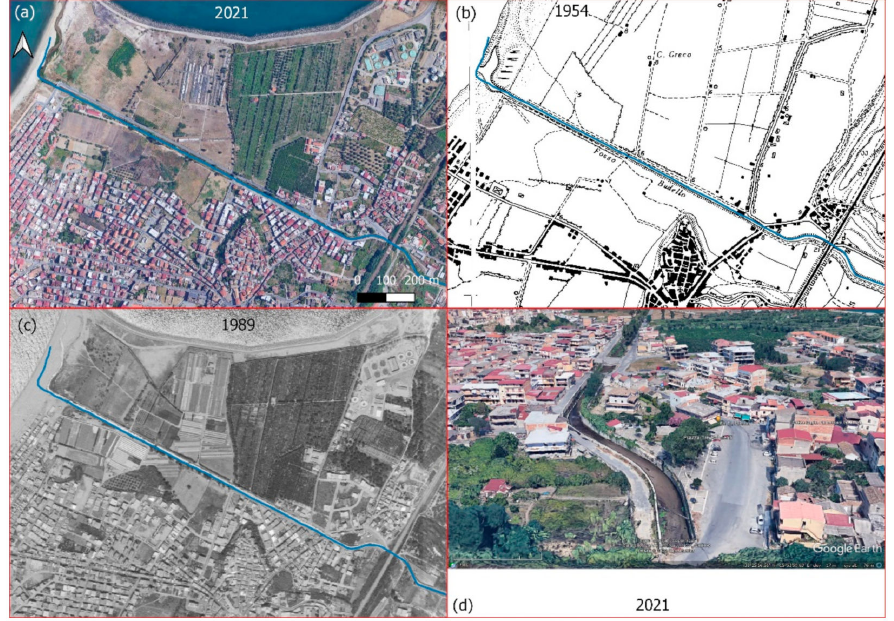
Figure 14. The Budello River. ( a ) An image from Google Earth from September 2021. ( b ) The CASMEZ cartography from 1954. ( c ) The orthophoto from 1989. ( d ) The view of the river towards downstream (source: Google Earth). The blue line is the Budello